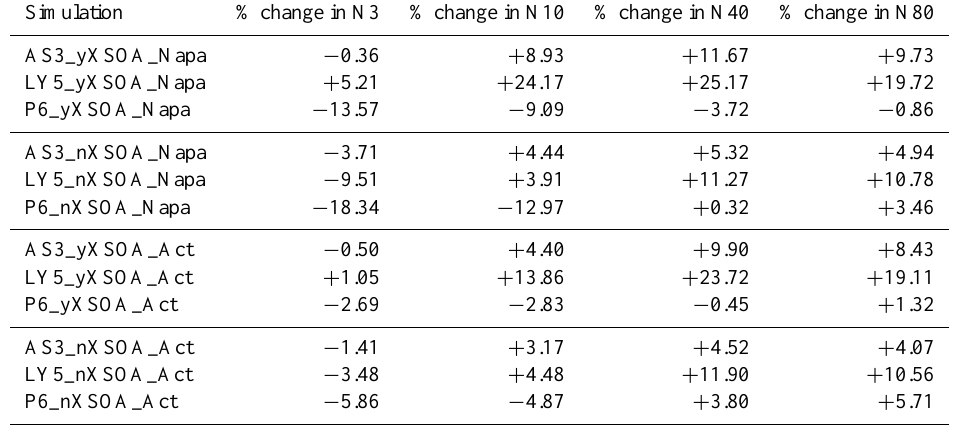
Table 2. Changes in globally, annually averaged N3, N10, N40 and N80 attributable to sub-grid sulphate emissions. Each simulation is compared to the NoSGS case with the same SOA emissions and the same grid-resolved nucleation scheme. Simulation